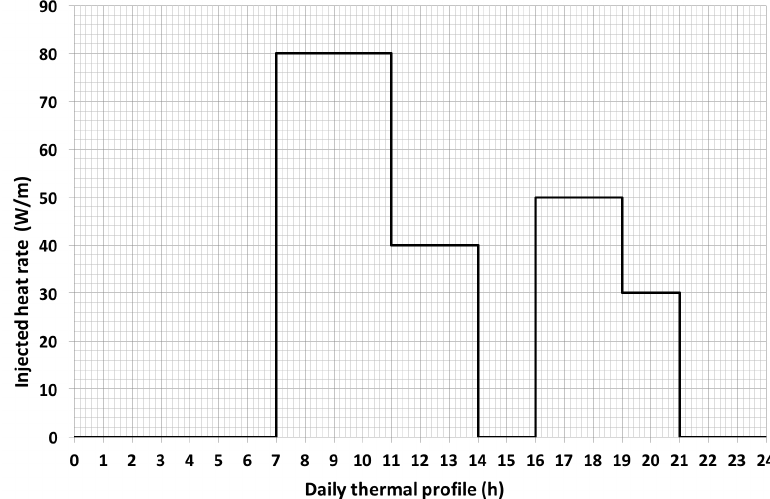
Figure 8. Daily profile of the test (Monday to